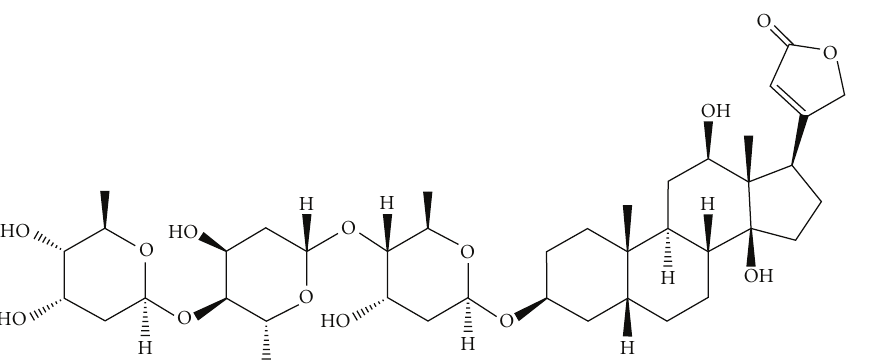
Figure 1: Chemical structure of digoxin (C 41 H 64 O 14 ).